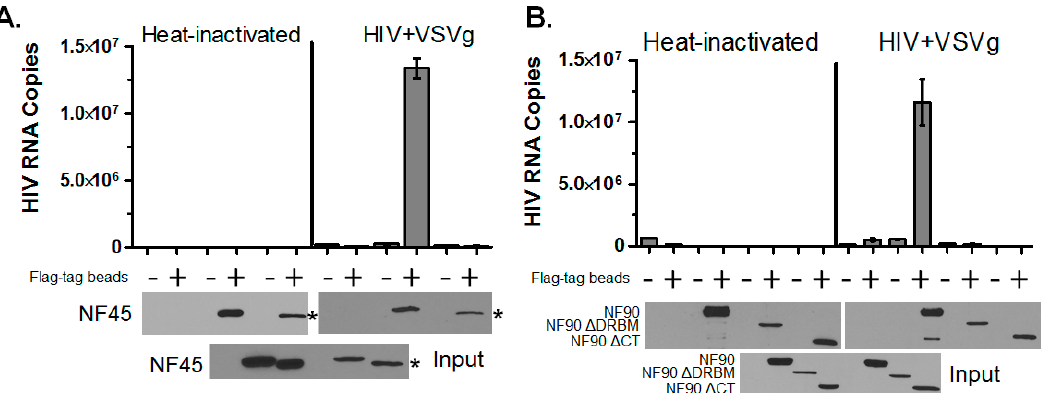
Figure 6. NF45 and NF90 interact with HIV RNA. ( A , B ). Cells were infected for 24 h with Heat inactivated virus or HIV+VSVg as indicated and protein-RNA complexes isolated with indicated antibodies (( − ) = isotype control beads and (+) = flag tag beads). Immunoprecipitates were digested with PK prior to RNA isolation and HIV binding detected by real-time PCR using late RT primers. Immunoblots were used to confirm the expression (input) and capture (output) of proteins (* denotes NF45 Δ RGG).